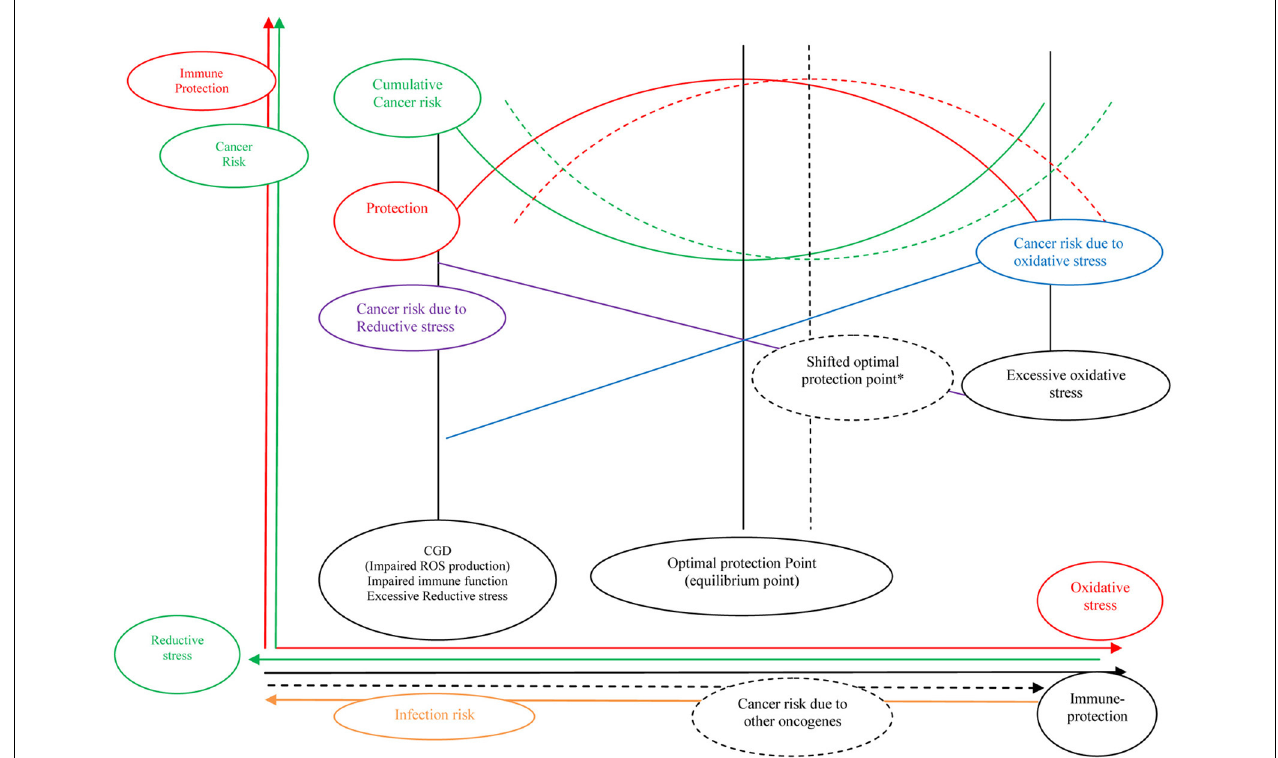
FIGURE 2 | There is no unit and all figures are representing increase and decrease in parameters, curves, and arrows are representing hypothetical relationship between parameters. ∗ Both high levels of ROS and antioxidants are carcinogen; however it seems that in certain conditions such as tuberculosis and smoking slightly increased ROS